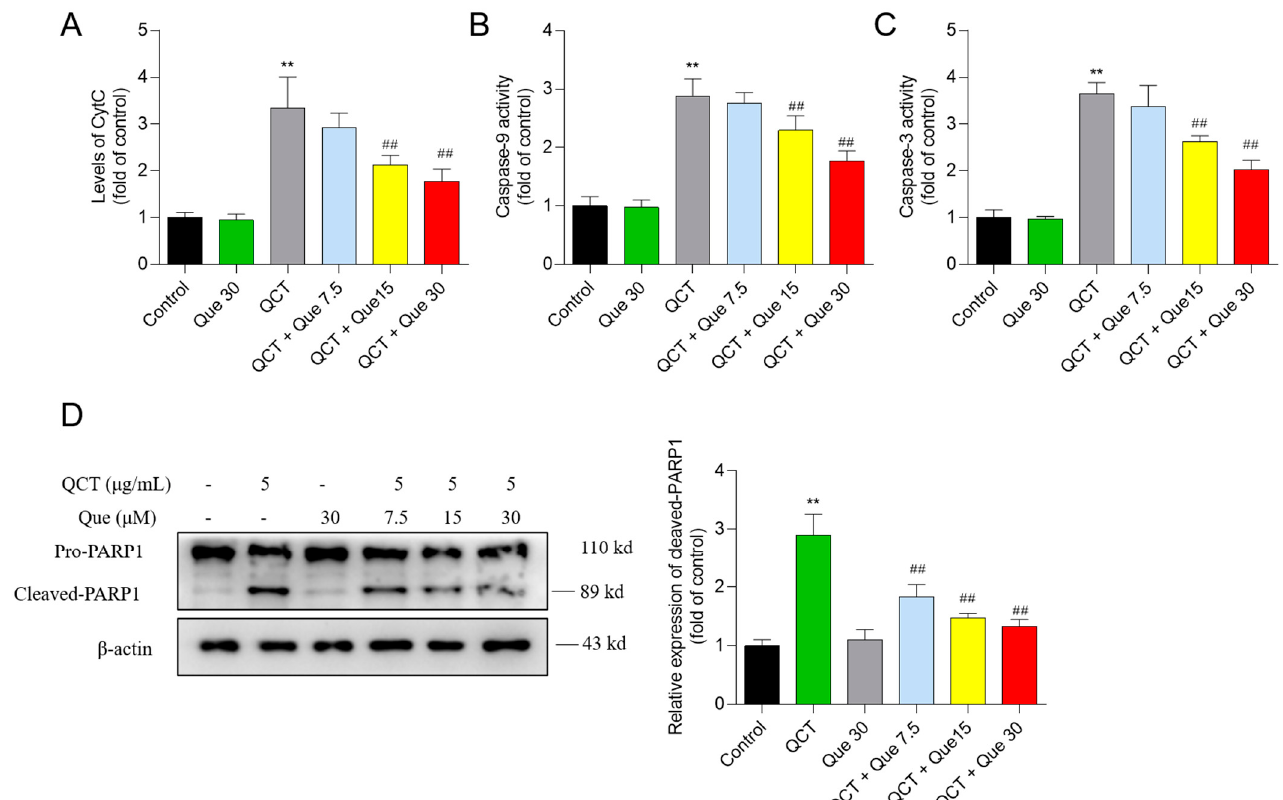
Figure 6. The changes of CytC levels ( A ), caspase-9 ( B ) and caspase -3 ( C ) activity, and cleaved-PARP1 protein expression ( D ). All results were presented as mean ± SD ( n = 4 independent experiments). ** p < 0.01, compared to the vehicle control group; ## p < 0.01, compared to the QCT-alone group. QCT, quinocetone; Que, quercetin.